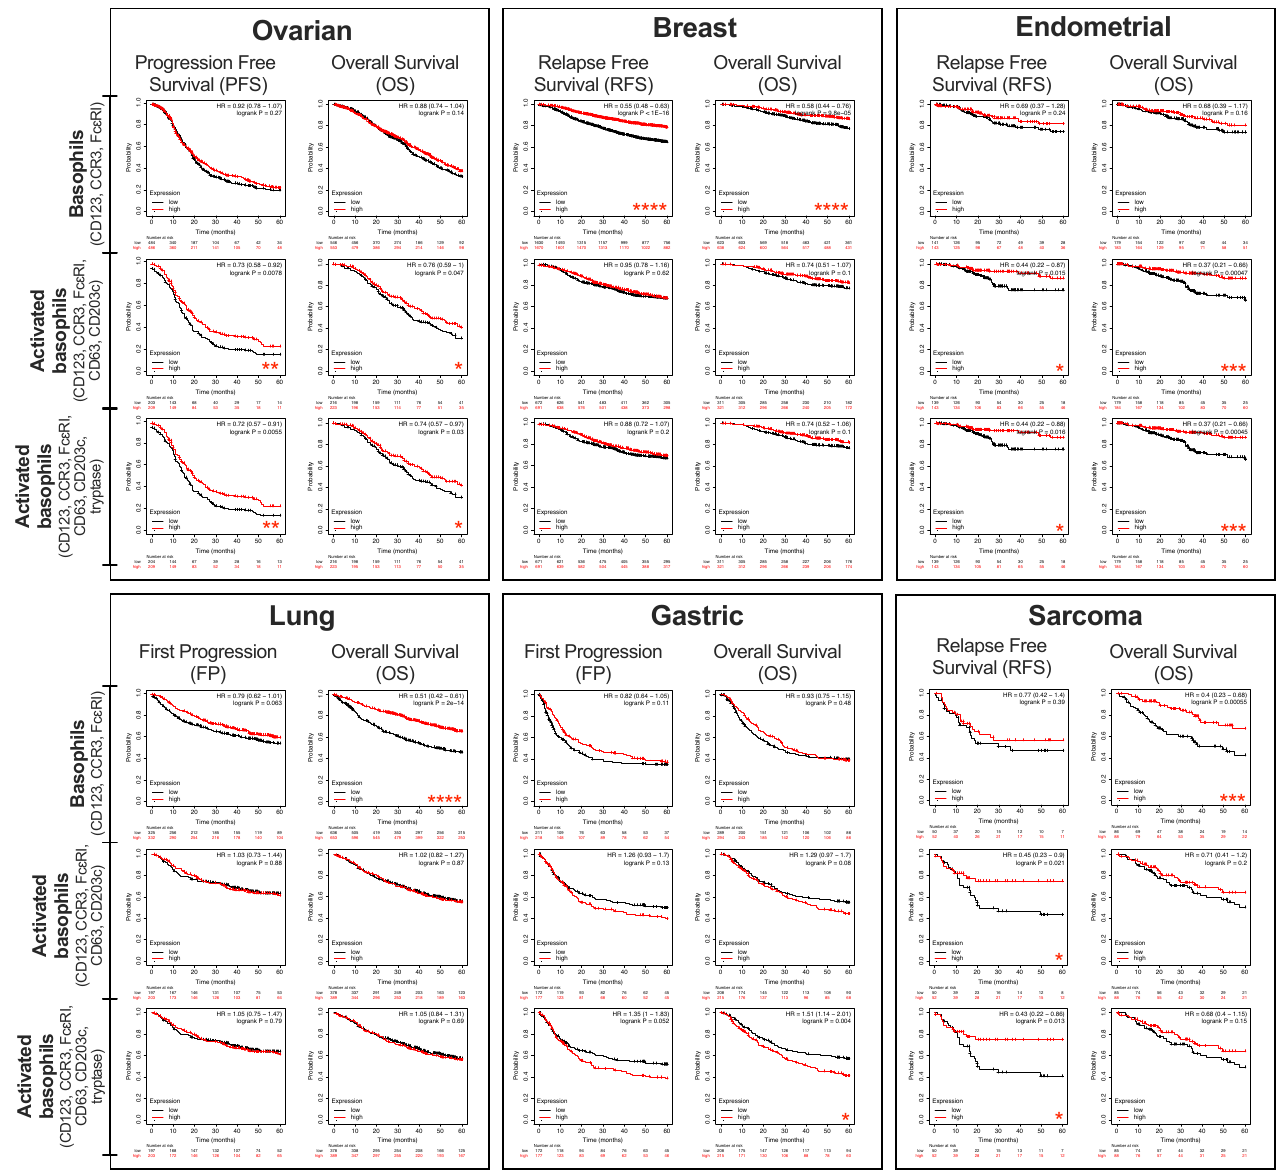
Figure 2. Tumor-resident basophils and associations with cancer patient outcomes. Survival outcome analysis performed using the Kaplan–Meier (KM) Plotter online tool (https://kmplot.com/analysis/, accessed on 7 December 2021) [71]. Gene expression analyses of tumor-resident basophils (CD123, CCR3, and Fc ε RI) and activated basophil signatures (CD123, CCR3, Fc ε RI, CD63, CD203c ± tryptase) were performed. Patients’ survival was analyzed up to 60 months. Groups of patients were selected based on combined gene expression levels of selected basophil markers in tumor lesions, grouped into top tertile (T3) and lower tertile (T1), while patients in the middle tertile (T2) were excluded. Markers (Gene Probe ID): CD123 (206148_at); CCR3 (208304_at); Fc ε RI (211734_s_at); CD63 (200663_at); CD203c (232737_S_at) and tryptase (210084_x_at). Summary of n numbers (number of individuals at risk) can be found in Supplementary Table S2. Data sourced through mRNA gene chip (ovarian, breast, lung and gastric) and mRNA RNA-Seq (sarcoma and endometrial). p values: * = p < 0.05, ** = p < 0.01, *** = p < 0.001, **** = p <